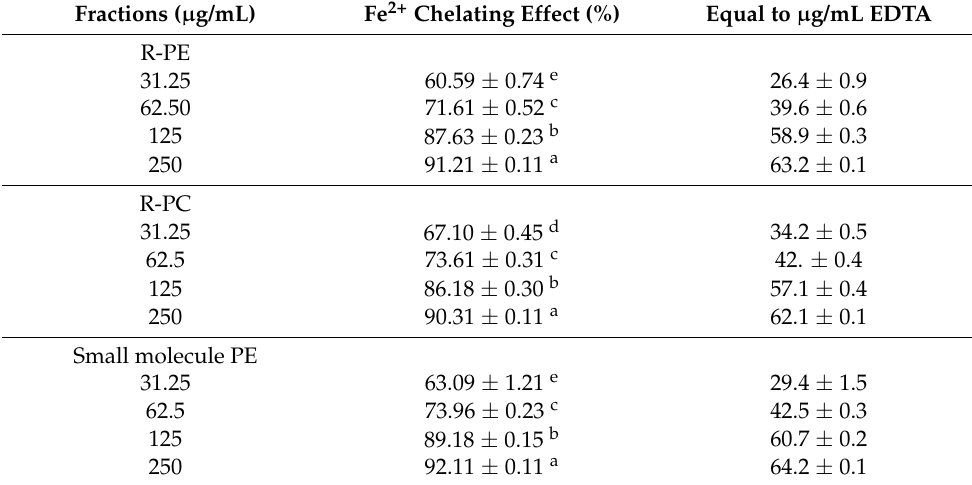
Table 6. Ferrous ion chelating activity of phycobiliprotein extracts from Porphyra.